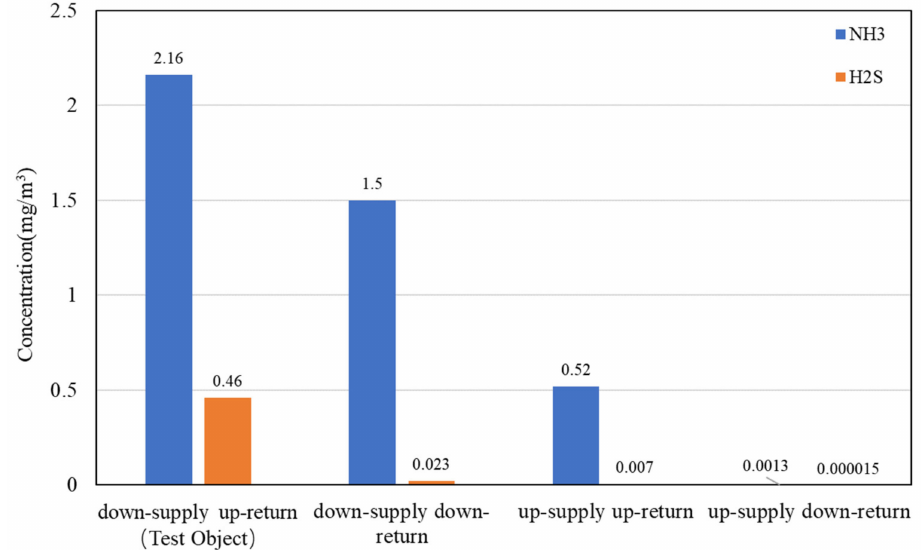
Figure 14. The aerosol concentration at the height of breathing under different ventilation